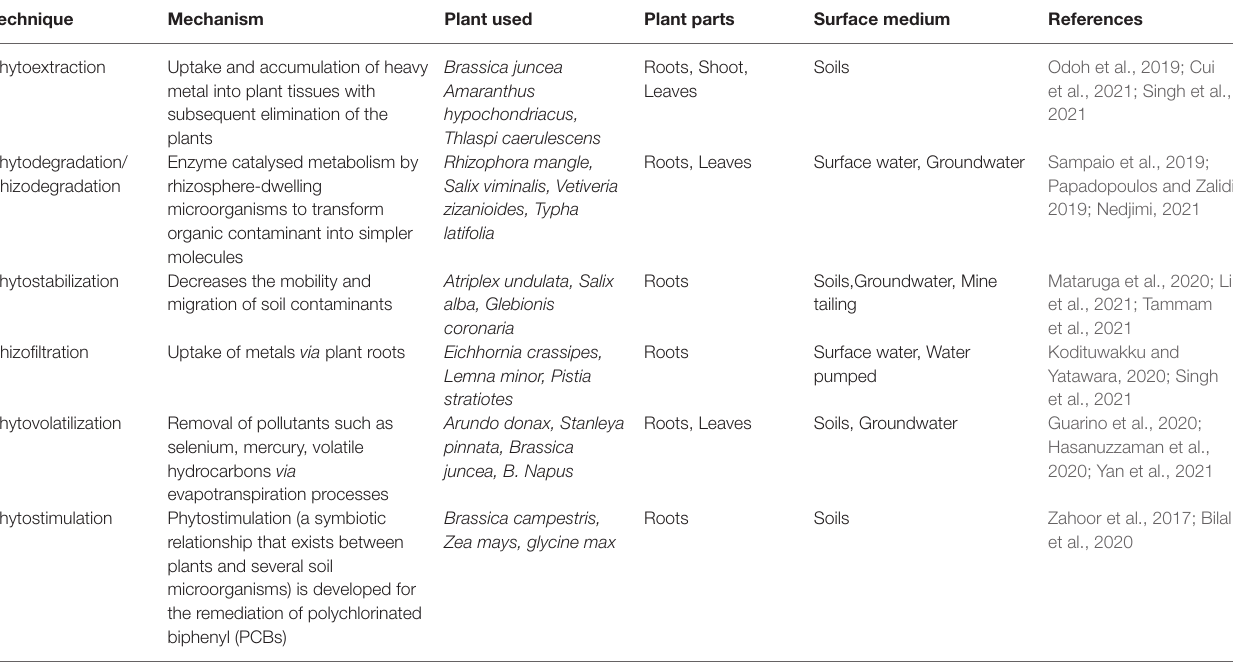
TABLE 1 | List of various phytoremediation mechanisms and plant species used in various